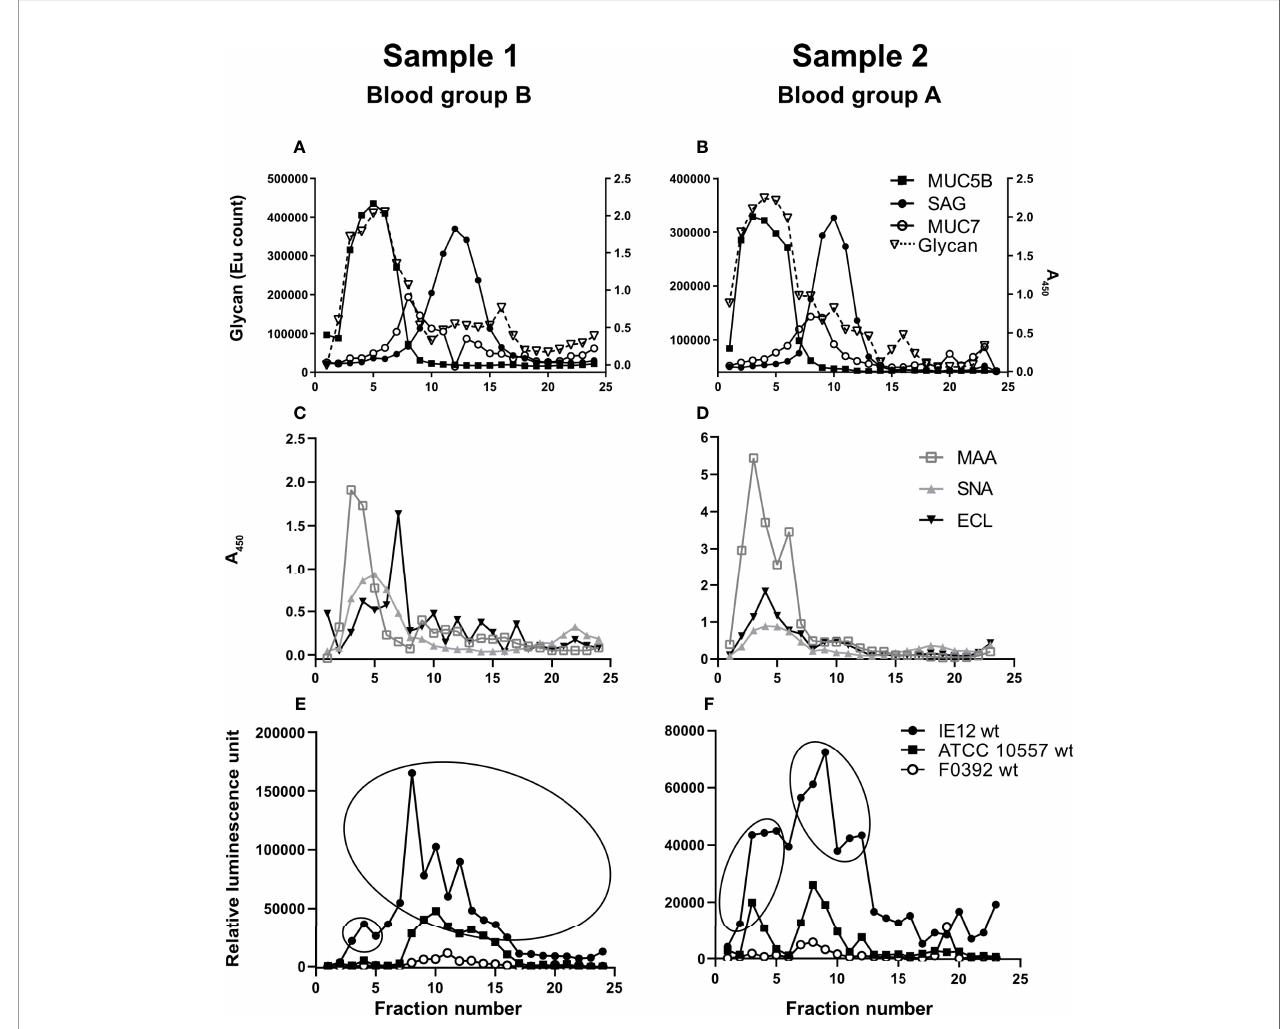
FIGURE 1 | Soluble salivary mucins and their binding to lectins and S. oralis . Fractions from CsCl density gradient centrifugation of the soluble saliva fractions were collected from the bottom of the tube (i.e. the low fraction numbers have the highest density), diluted 1:100 and analyzed for: (A, B) glycan content, MUC5B, MUC7 and SAG. (C, D) Fractions were probed with the lectins SNA-I for a 2,6-linked sialic acid, MAA for a 2,3-linked sialic acid and ECL for Gal b 1-related oligosaccharides. To visualize the MAA and ECL signals in the graphs, the signals were multiplied by 10. Please note that a stronger signal with one lectin than another does not imply that there is more of a certain structure and refer to the mass spectrometry results for comparison of the abundance between the glycans. (E, F) Fractions were assessed for S. oralis IE12 WT, ATCC 10557 WT and F0392 WT binding. For further analysis, fractions were pooled to obtain one MUC5B rich and one MUC7/SAG rich sample for each gradient in accordance with the